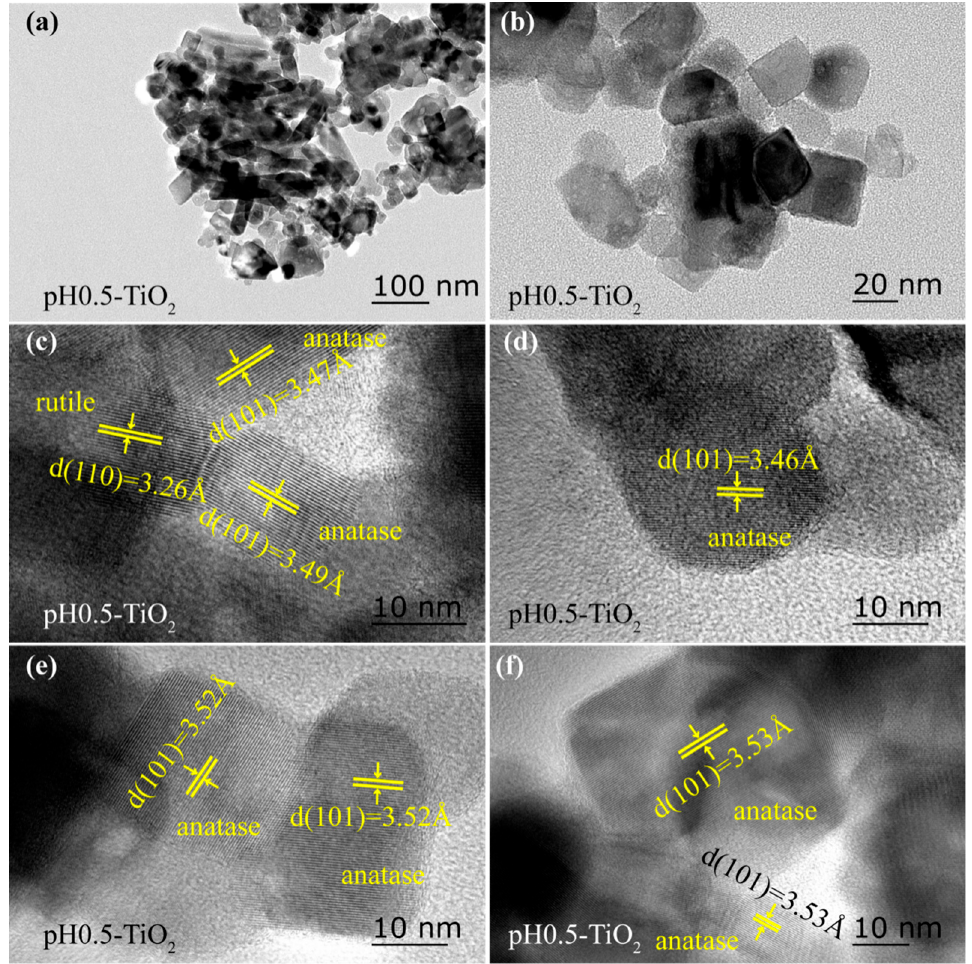
Figure 2. TEM ( a , b ) and HRTEM ( c – f ) images of the TiO 2 sample obtained at pH0.5 under hydrothermal conditions.